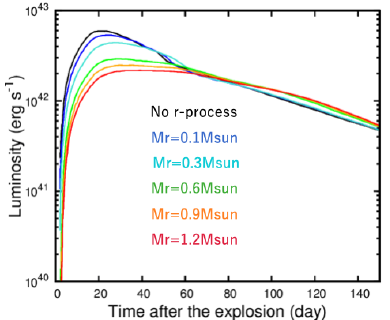
Figure 2. The light curves in each optical band. The solid lines show the model with no r-process elements while the dashed lines show the model with 0.3 M ⊙ of r- process